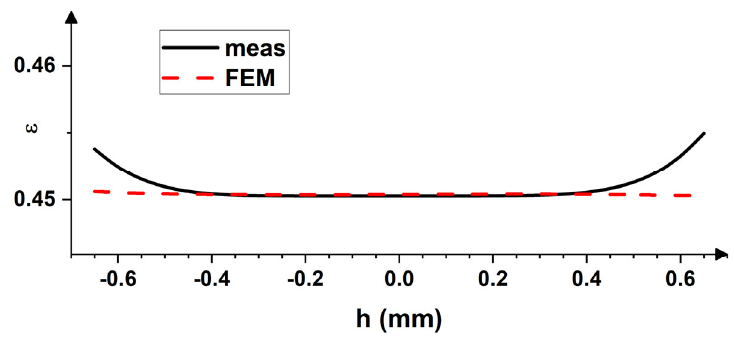
Figure 13. Distribution of equivalent strain across the thickness of asymmetrically rolled sheet.